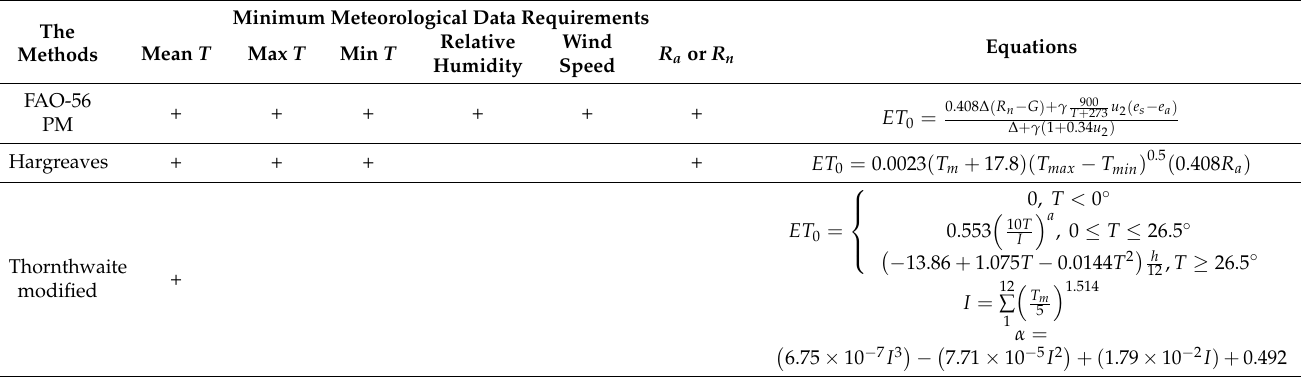
Table 2. FAO-56 PM, Har and Tho equations with required input data to calculate daily ET 0.